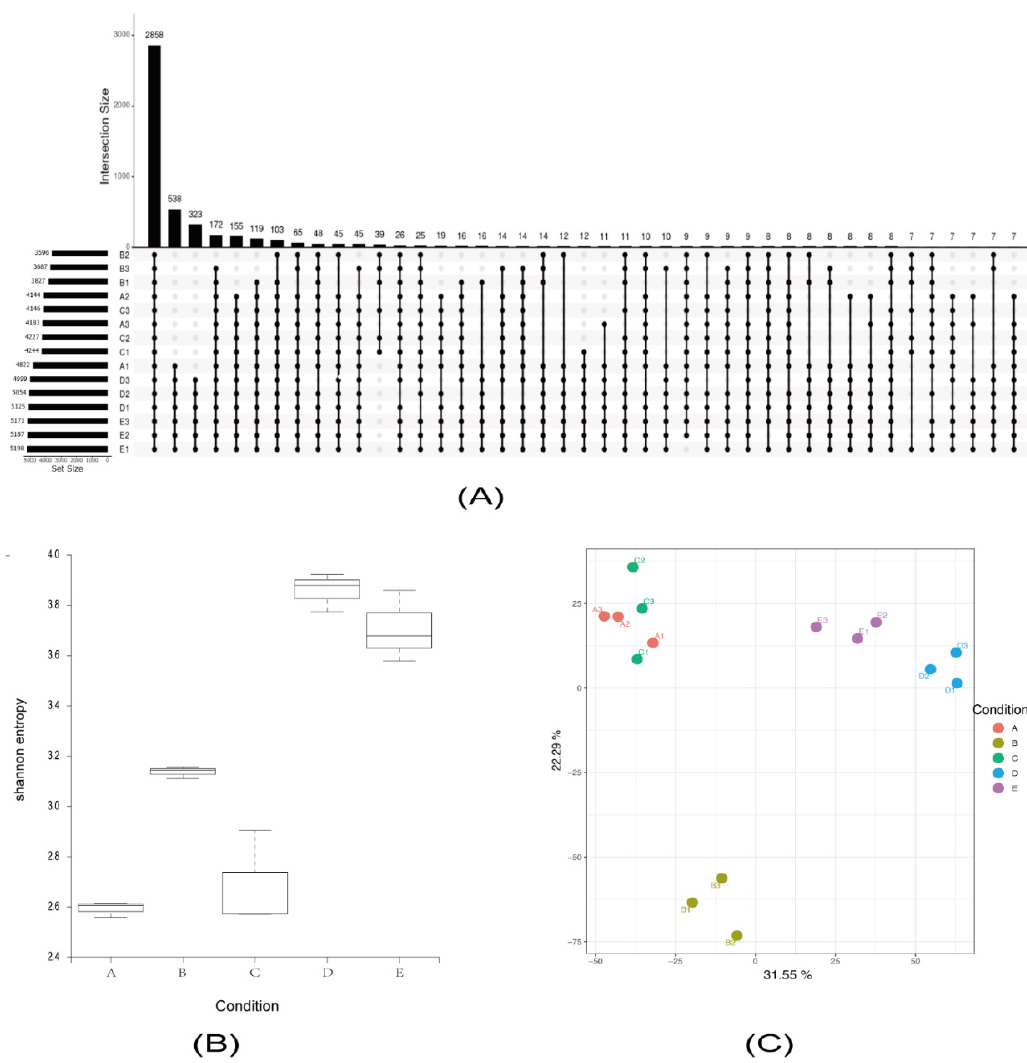
Figure 2. The microbial community analysis of 15 samples. ( A ) Upset plot shows the overlap infor- mation of species in each sample; ( B ) Shannon diversity; ( C ) principal component analysis (PCA)